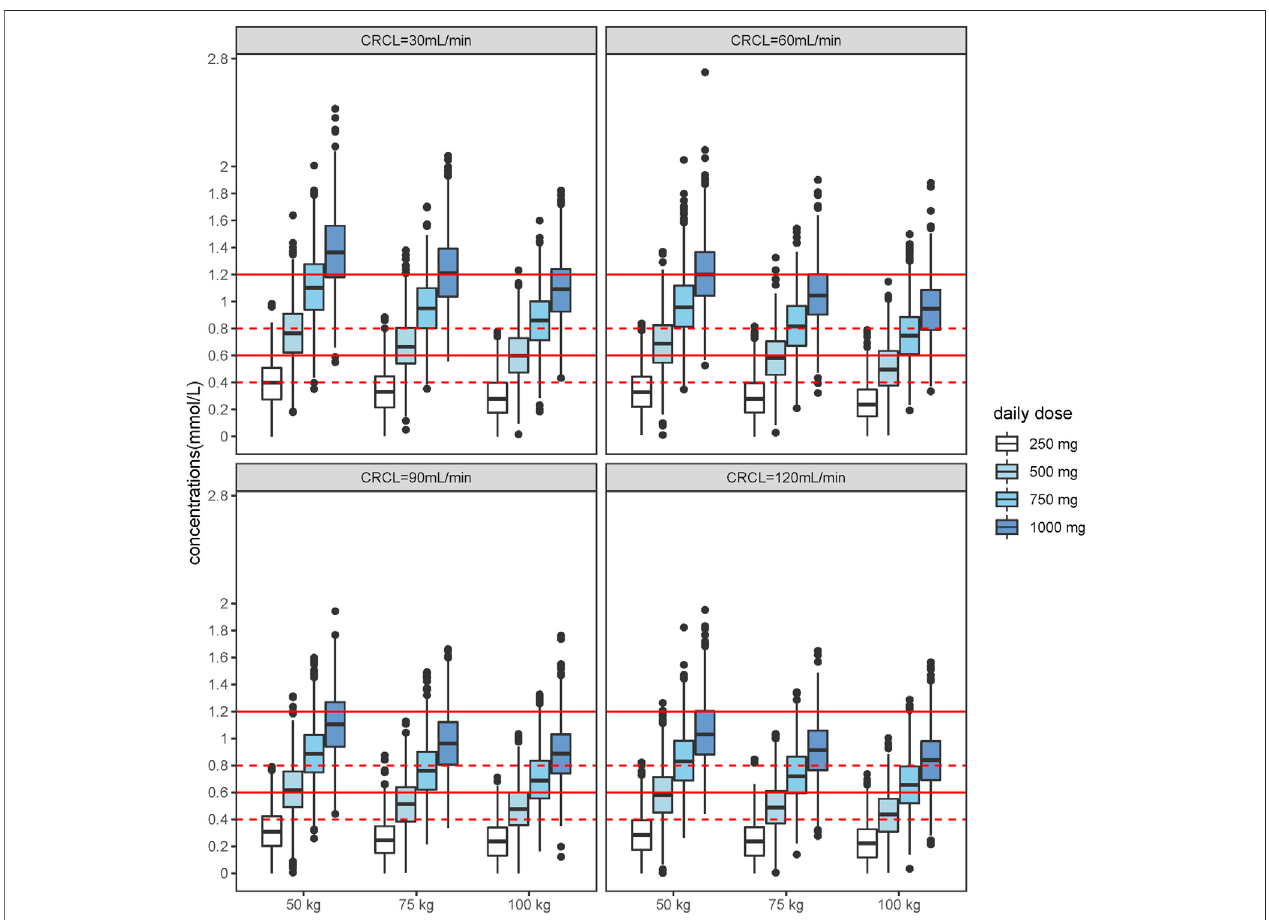
FIGURE 3 | Boxplot of the distributions of simulated steady state trough lithium concentrations for patients with different weight and CRCL levels. Patients with different weight levels from 50, 75, 100 kg, and CRCL levels from 30 ml/min, 60 ml/min, 90 ml/min, 120 ml/min were set for the simulation. Dashed horizontal lines represent the therapeutic target range (0.6 – 1.2 mmol/L) for the acute phase and point horizontal lines represent the therapeutic target range (04 – 0.8 mmol/L) for maintenance